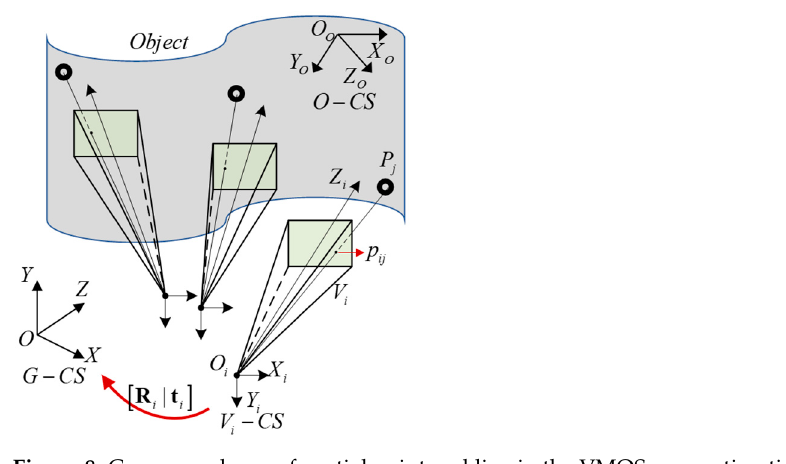
Figure 8. Correspondence of spatial point and line in the VMOS pose estimation. The correspondence between spatial point P j and the line O i p ij was established. Utiliz- ing the extrinsic matrix [ R i | t i ] , the line O i p ij was transformed from V i − CS to the VMOS coordinate system (i.e., G − CS ), as shown in Equations (10) and (11).